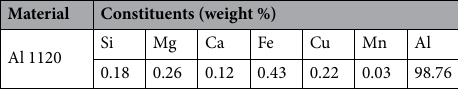
Table 1. Chemical composition of Al 1120.